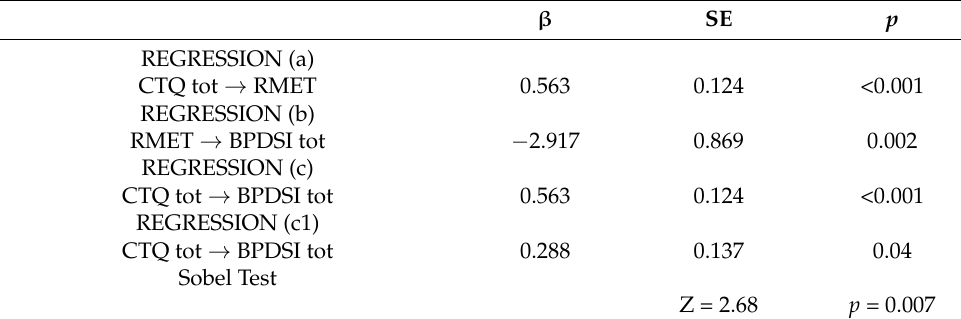
Table 4. Mediational model (M = RMET).